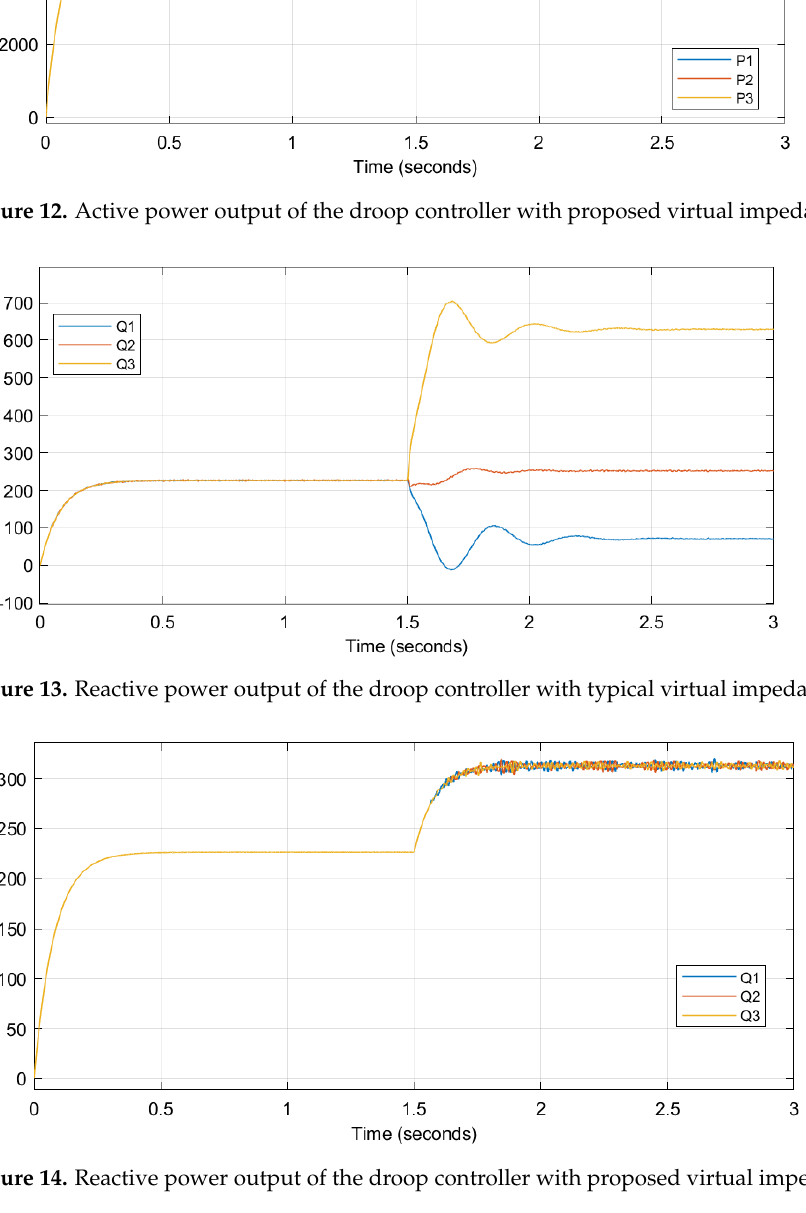
Figure 14. Reactive power output of the droop controller with proposed virtual impedance.